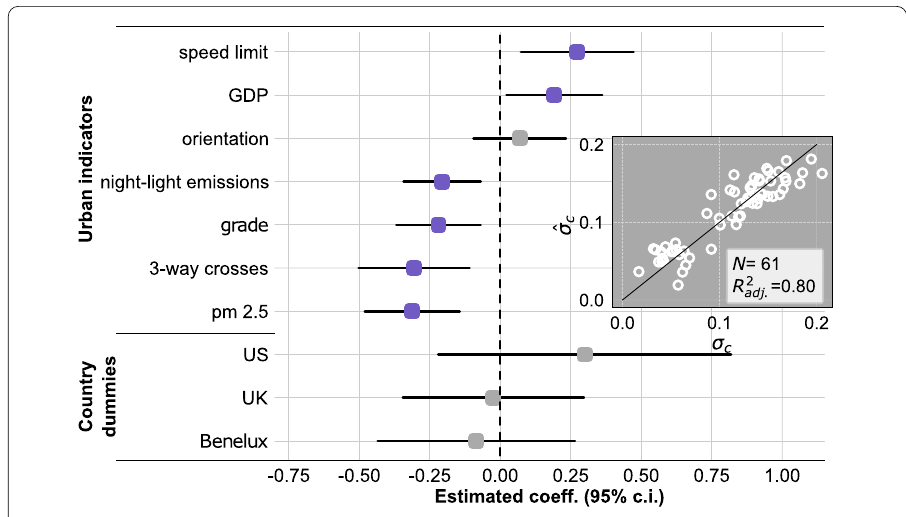
Figure 3 Regression analysis. The main plot shows the estimated coefficients (square markers) with 95% confidence intervals (black lines) for the final set of regressors included in the model. Model estimated via Ordinary Least Square, selection performed via exhaustive search. Selection criterion: Akaike Information Criterion (AIC). Statistically significant coefficient at 0.05 significance level are pictured in purple. The